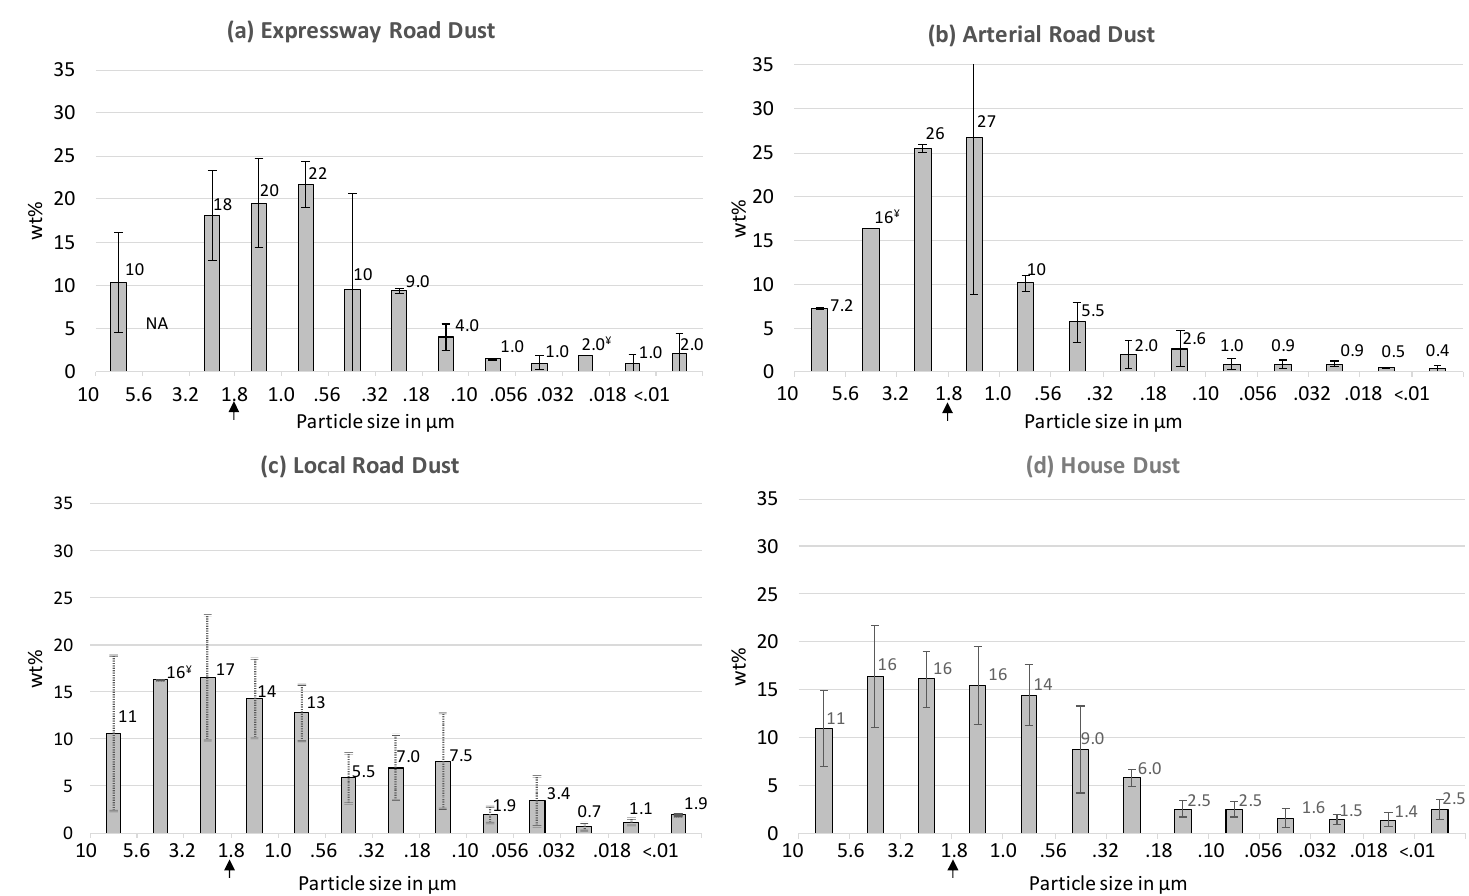
Figure 1. Particulate matter (PM) mass distribution profiles for ( a ) expressway dust, ( b ) arterial road dust, ( c ) local road dust and ( d ) house dust. Weight of each fraction was divided by total weight of all fractions, expressed as % by weight (= wt%). Error bars for road dust profiles = standard deviations of triplicate runs unless indicated otherwise (NA = no filters passed QC/QC criteria, ¥ = only one filter passed); error bars for house dust = standard deviations of four different homes; fine particles defined as <1.8 µm in this study (indicated by the vertical arrow). See supplementary material (Figure S1) for details of individual homes.